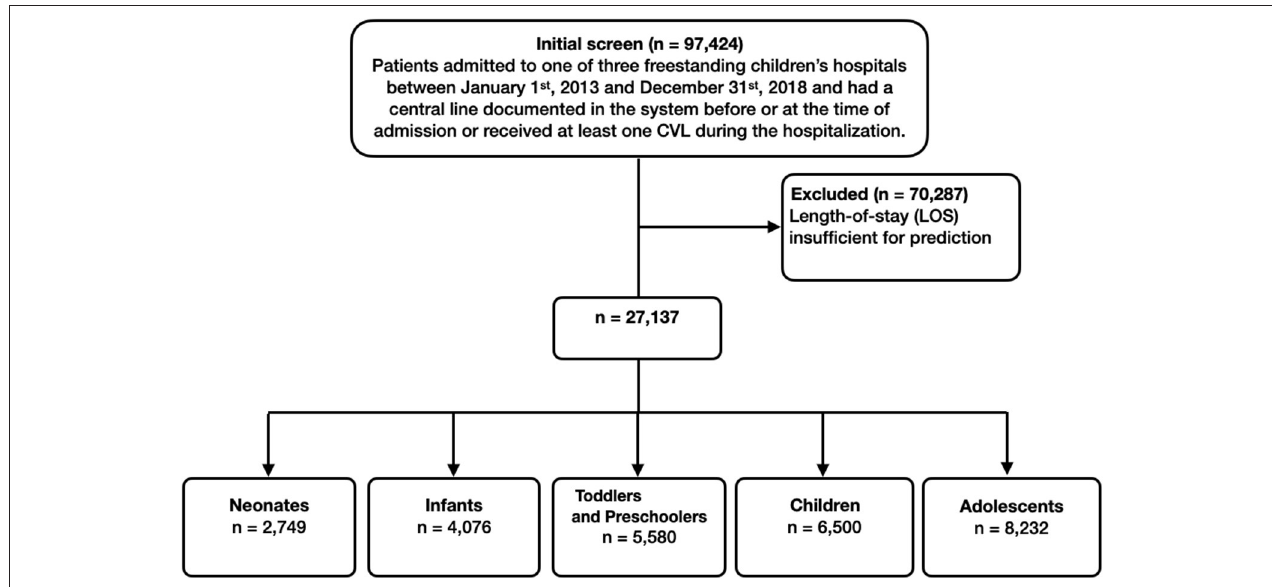
FIGURE 2 | Inclusion flowchart. The final number of patient visits that we used in training and testing the machine learning models were